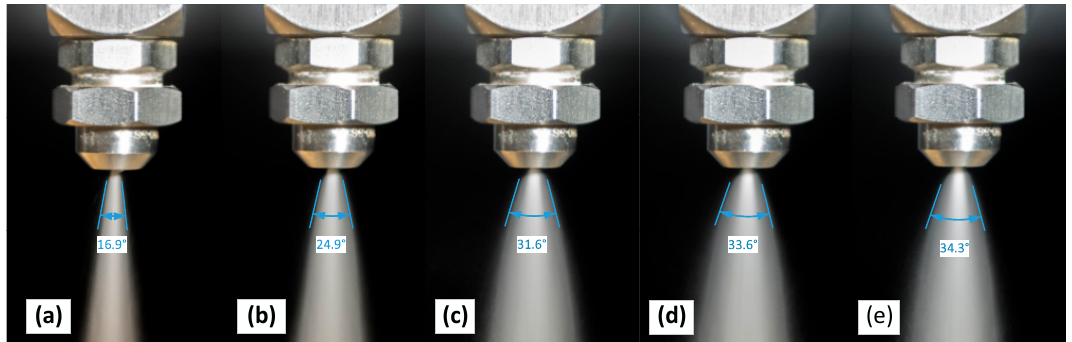
Figure 4. Photographic views of spray angle with PDWIC, ( a ) P diff = 51.90 kPa, ( b ) P diff = 93.73 kPa, ( c ) P diff = 145.85 kPa, ( d ) P diff = 201.61 kPa, and ( e ) P diff = 235.35 kPa.